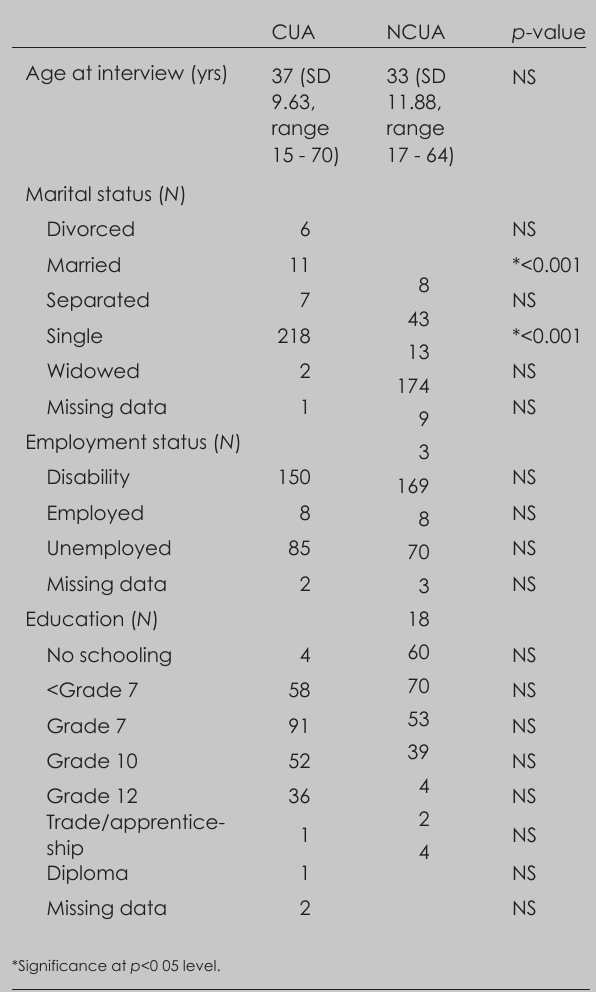
Table I. Comparison of demographic variables between can- nabis users/abusers (CUA) and non-cannabis users/abusers